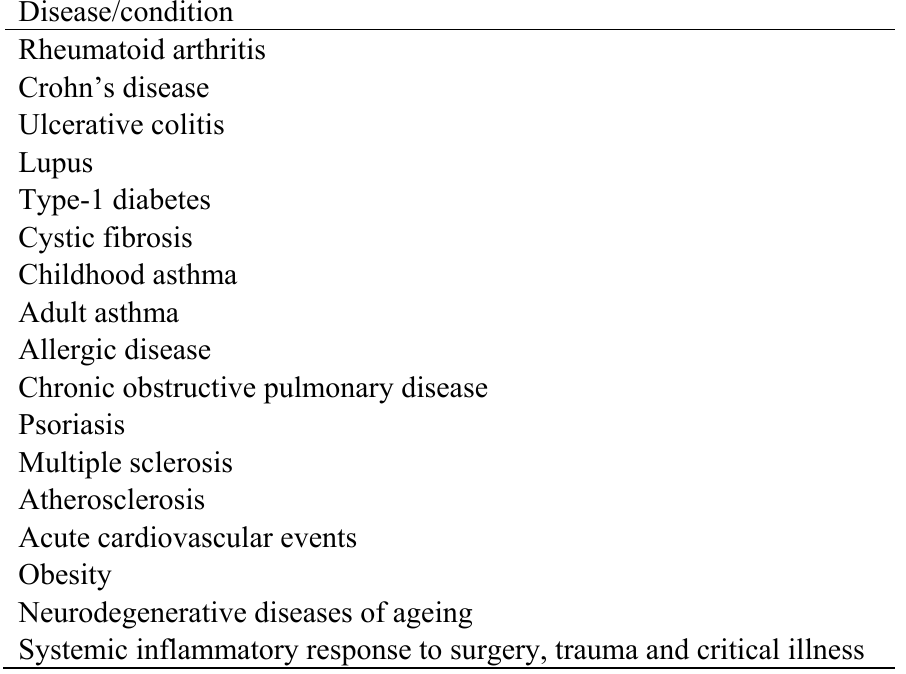
Table 1. List of diseases and conditions with an inflammatory component in which marine n-3 fatty acids might be of benefit. Note: this list is not